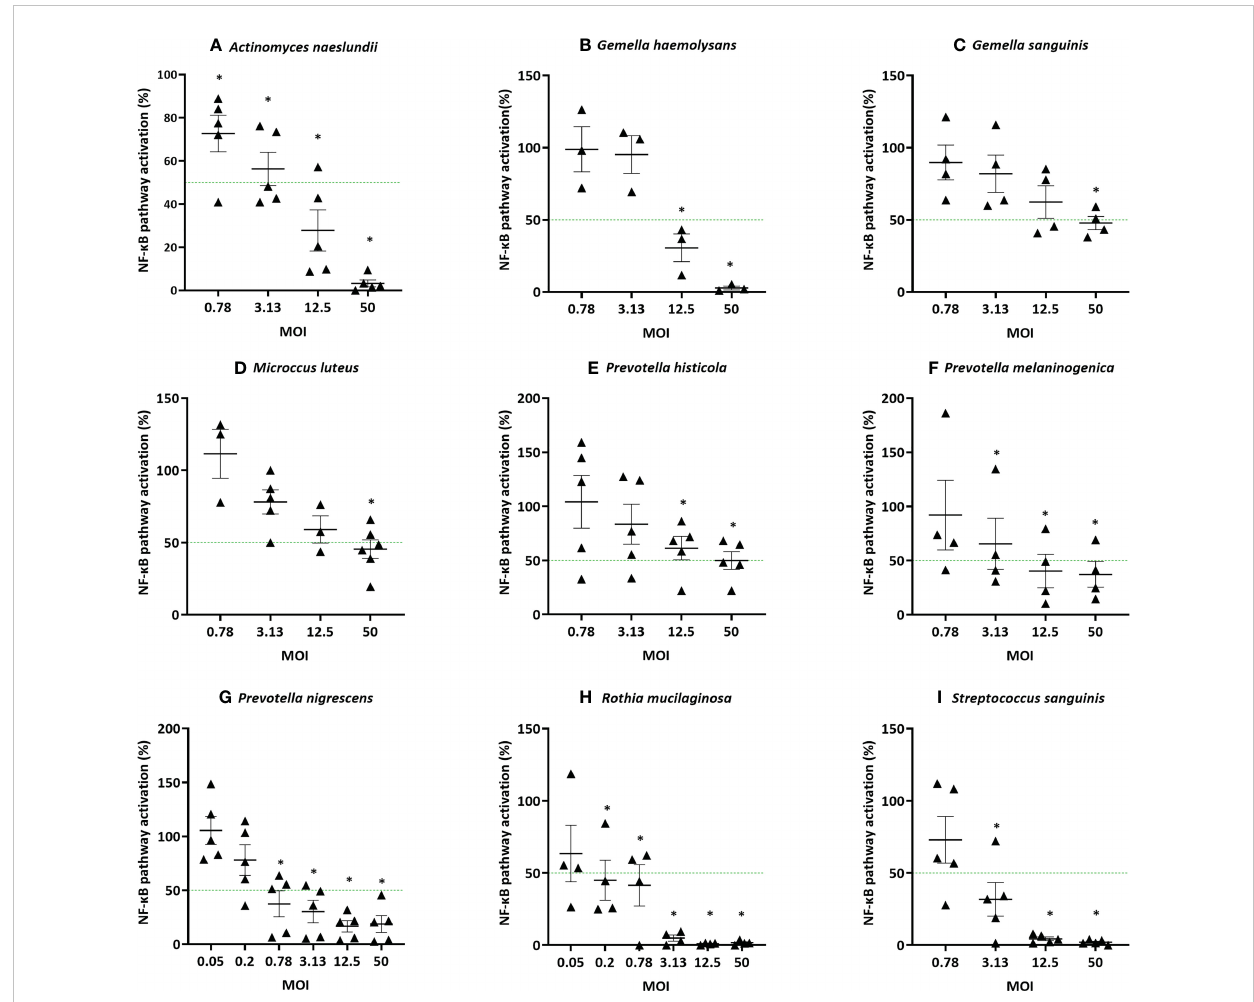
FIGURE 4 Determinationofthe minimal effectiveMOI(mMOI NF- k B )of commensal bacteriabasedonNF- k Bpathway activationin(3D)A549 luciferaseNF- k B-reporter cells. SelectedlungcommensalsatdifferentMOIwere cultured withLPSandthemMOI NF- k B wasdeterminedby aNF- k Bluciferase assay,with (A) A. naeslundii , (B) G.haemolysans , (C) G.sanguinis , (D) M.luteus , (E) P.histicola , (F) P.melaninogenica , (G) P. nigrescens , (H) R. mucilaginosa , (I) S. sanguinis .Onthevertical axis%NF- k Bpathwayactivation compared toLPS-stimulatedcellsisshown, onthehorizontalaxisthetestedMOI isdepicted. ThemMOI NF- k B wasde fi nedas thelowestMOIwithanti-in fl ammatory activity (i.e.< 50%NF- k Bpathway activationcomparedtoLPS-stimulatedcellsasvisualizedby agreenline,p< 0,05). *:p< 0.05, n ≥